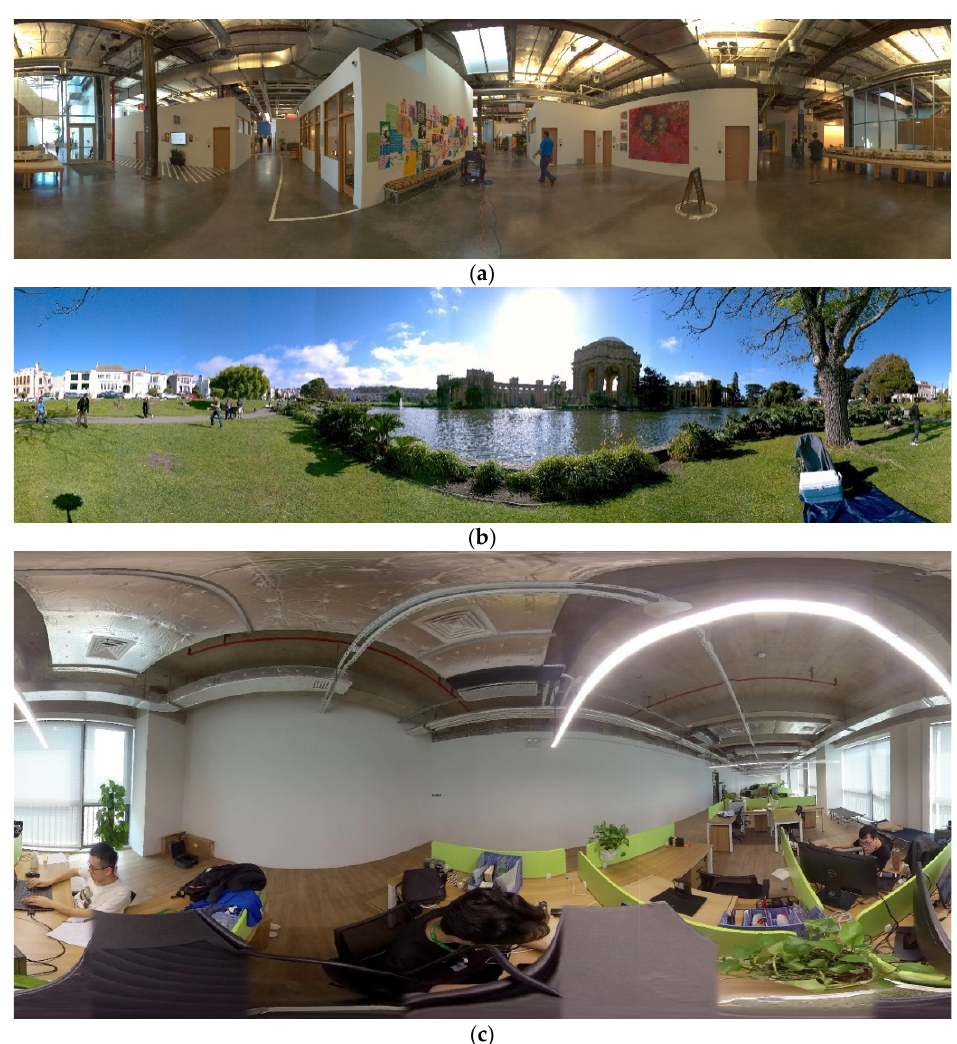
Figure 9. ‘Ours’ panoramic images. ( a ) scene1; ( b ) scene2; ( c ) fisheye.